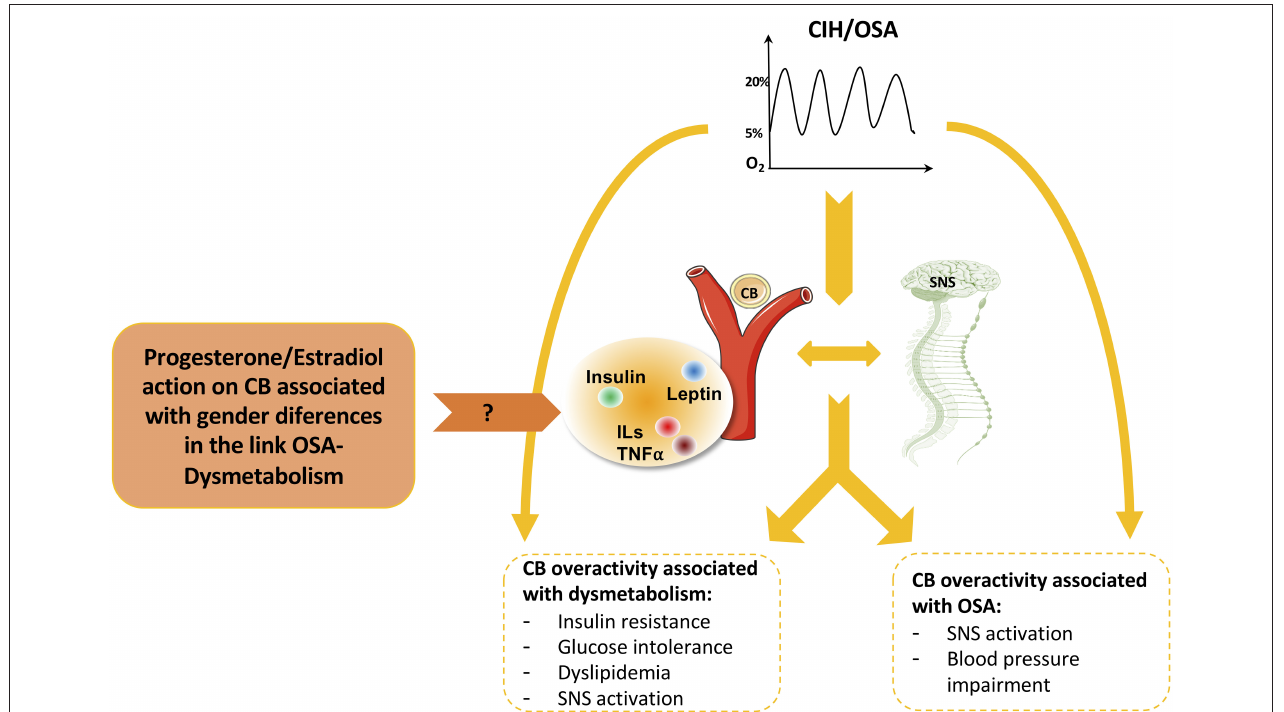
FIGURE 2 | Role of carotid body (CB) and sympathetic nervous system (SNS) on the cardiometabolic pathological features associated with obstructive sleep apnea (OSA) and the possible effect of progesterone and estradiol in mediating these effects. In addition to the direct effects of OSA on dysmetabolism and cardiovascular function, CB and SNS overactivation have also an interplay in the association of CIH/OSA-dysmetabolism with impact on insulin sensitivity, glucose tolerance, lipid metabolism, and blood pressure. Many molecules have been described to have a role in this relationship by acting at the level of CB namely insulin, leptin, and inflammatory molecules, which are deregulated in conditions of cardiometabolic diseases. Based on the previous description of the existence of receptors for sexual hormones, such as estradiol and progesterone, in the CB, and knowing the impact of these hormones on the differences in the prevalence of OSA and associated dysmetabolic states between men and women we can speculate that progesterone/estradiol on the CB must have a role on the gender-specific OSA-dysmetabolism